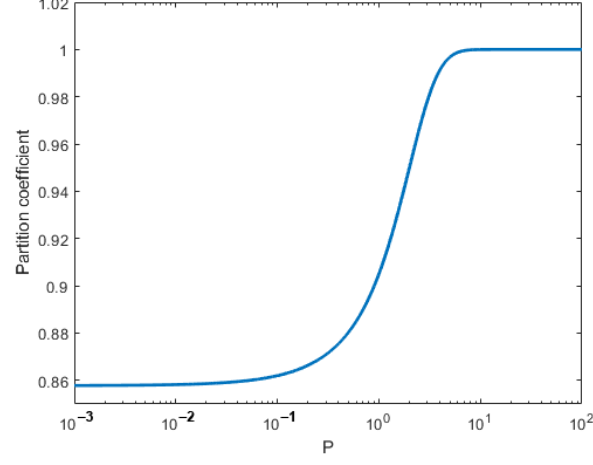
Figure 2. Variation of concentration profile for different Péclet numbers P .